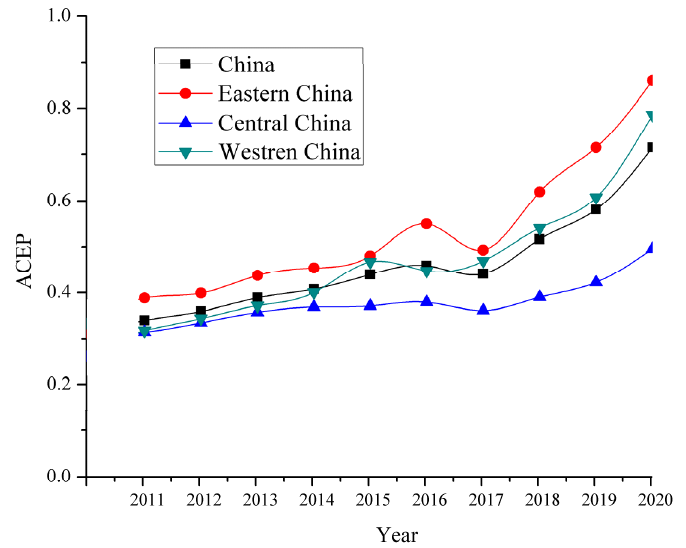
Figure 2. The trend of ACEP in three geographical regions of China between 2011 and 2020.